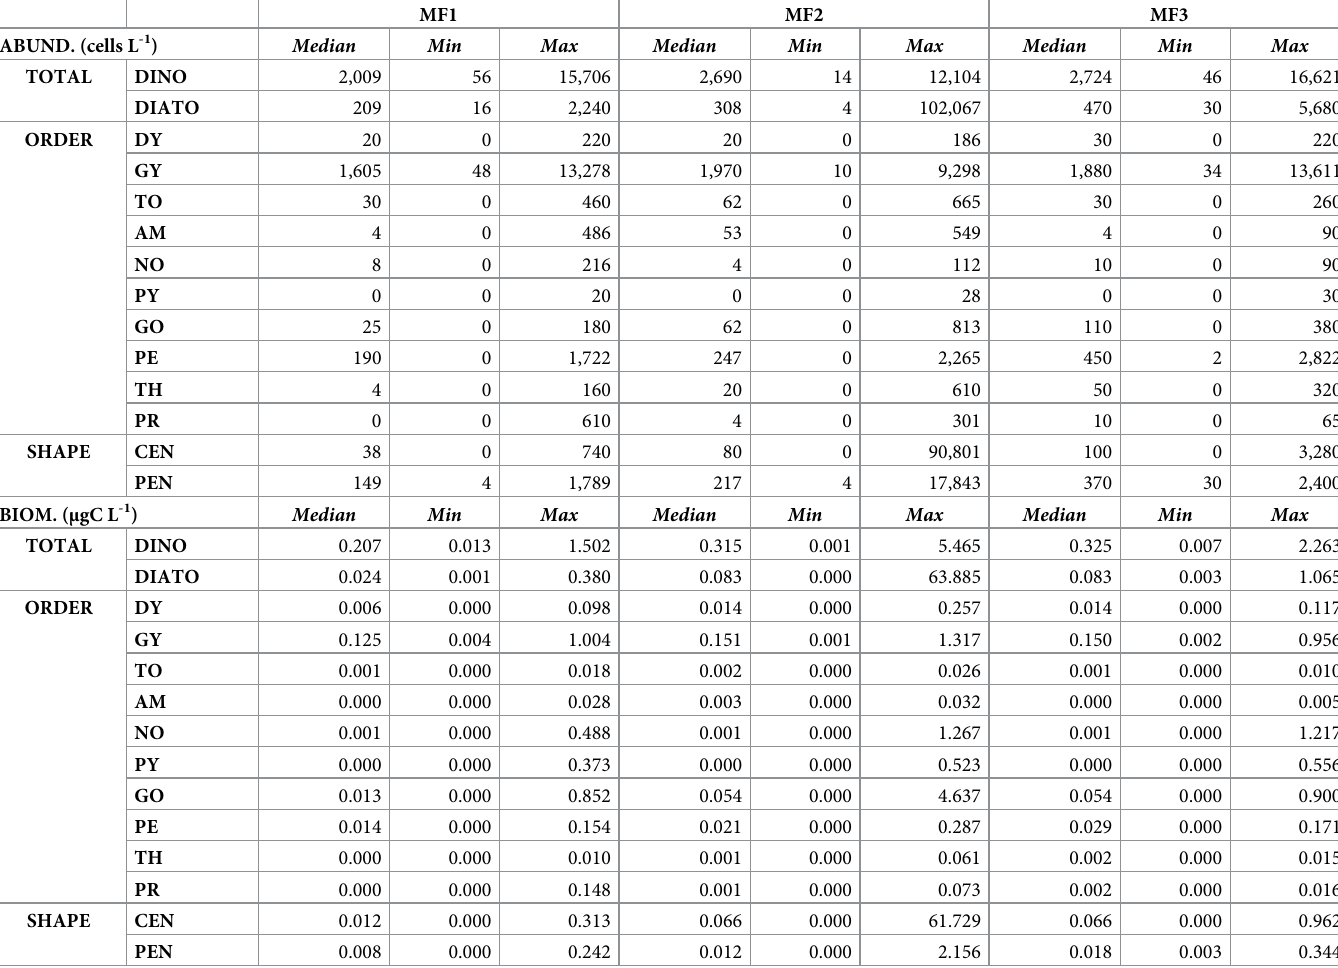
Table 2. Per-cruise abundance (cells L -1 ) and carbon biomass ( μ g C L -1 ) of dinoflagellates and